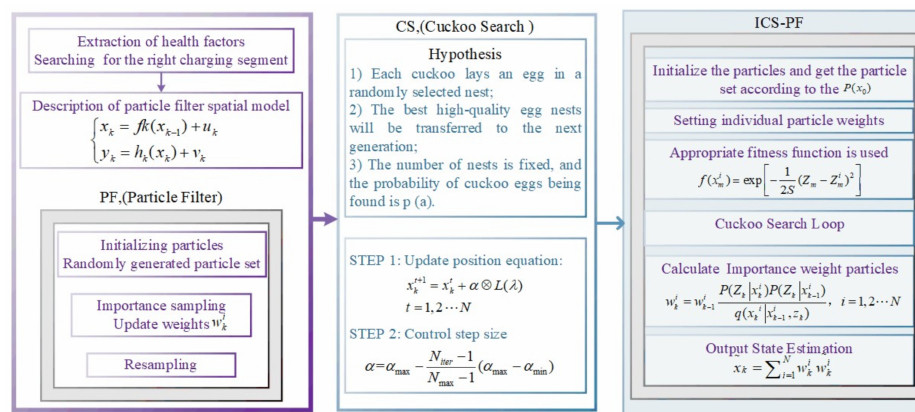
Figure 3. Calculation procedure.